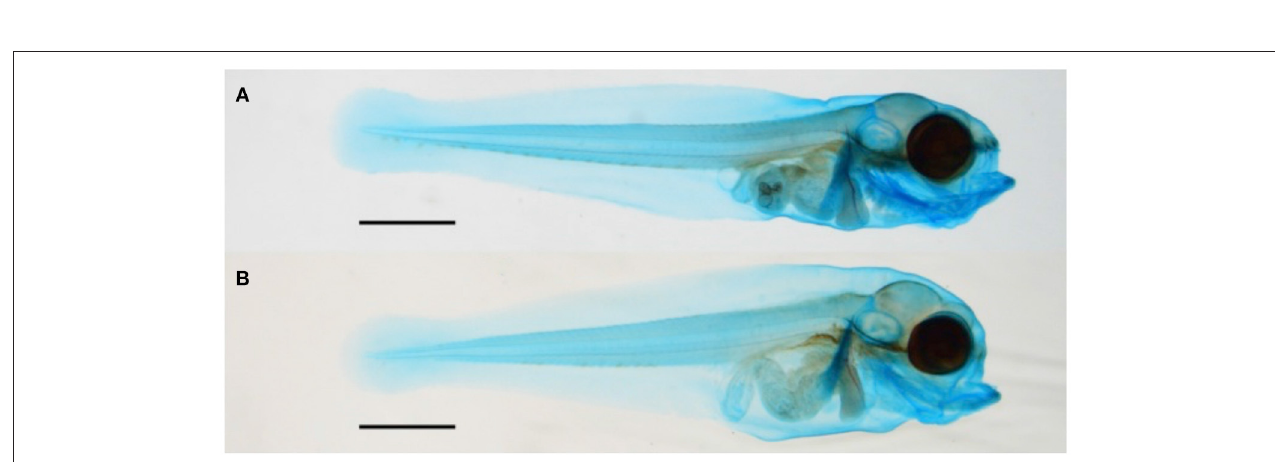
FIGURE 3 | Images of (A) control Atlantic haddock larvae compared with (B) high treatment group larvae of approximately equal standard length at 19 dph. The shorter upper jaw of high treatment group larvae is clearly seen. Scale bars: 1mm.